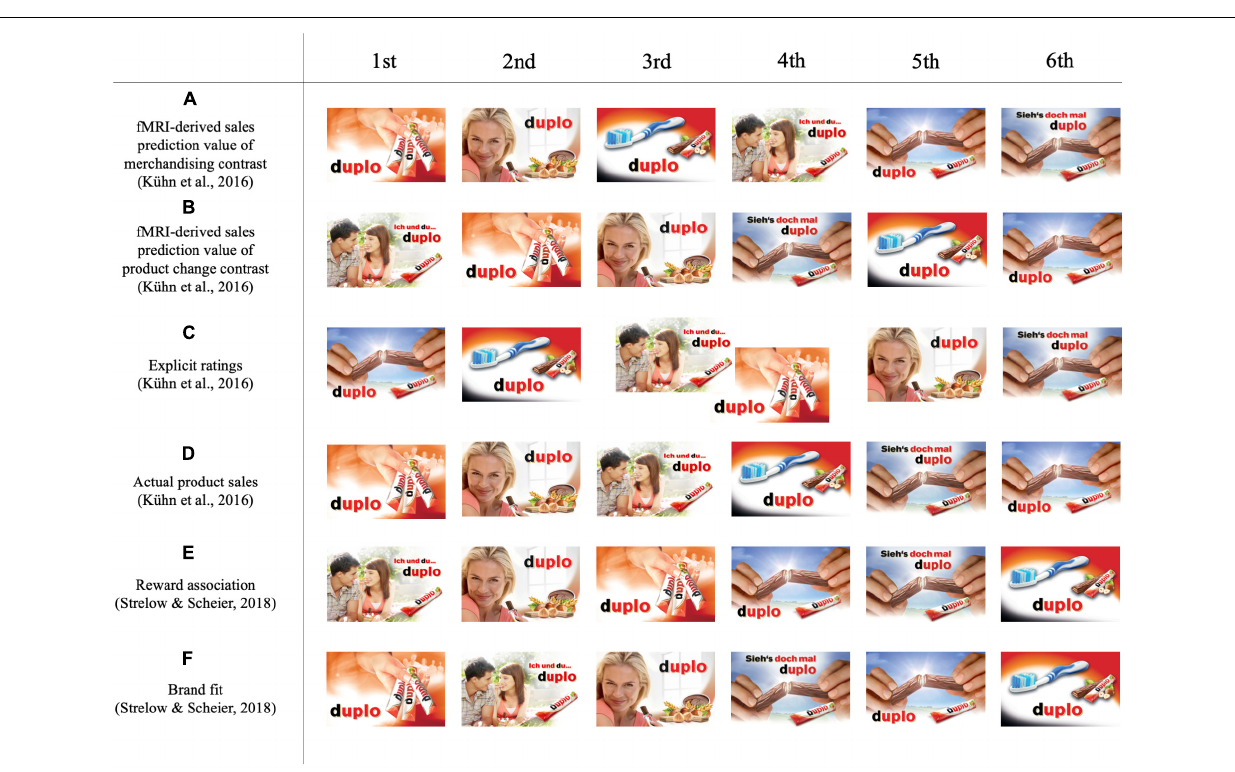
FIGURE 2 | Ranking of the six merchandising elements based on prior research. Ranking order of the merchandising elements derived from: (A) fMRI-derived sales prediction value of merchandising elements from Kühn et al. (2016); (B) fMRI-derived sales prediction value of product contrasts from Kühn et al. (2016); (C) the explicit rating of participants of the study by Kühn et al. (2016); (D) actual product sales of the field study of Kühn et al. (2016); (E) mean average reward association strength by Strelow and Scheier (2018); (F) brand-fit score of reward association by Strelow and Scheier (2018). Figure adapted from Kühn et al. (2016) and Strelow and Scheier (2018). Permission to reuse has been